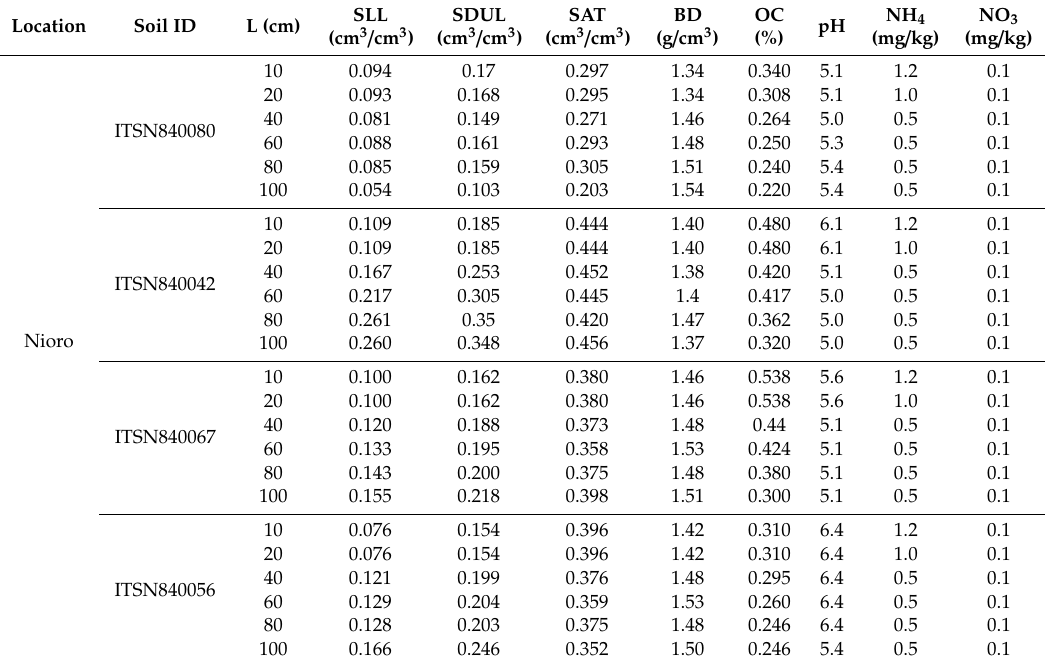
Table 1. Soil parameters used in simulations for Nioro, Senegal.